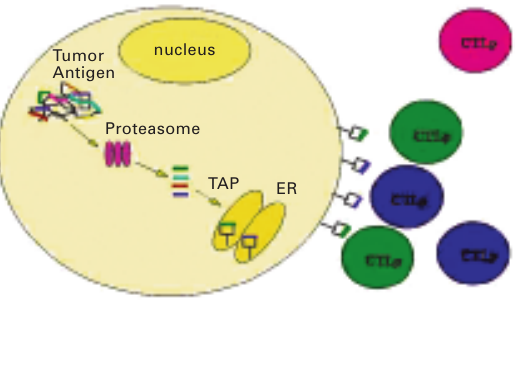
Figure 1 Peptide processing. Proteins in the cyto- plasm of cells are degraded by the pro- teosome complex, yielding short pep- tide fragments. A subset of these pep- tides are transported from the cytoplasm to the endoplasmic reticulum (ER) by transporter associ- ated protein (TAP). Once in the ER, the peptides can associ- ate with major histo- compatibility com- plex (MHC) class I molecules and move to the cell surface. Once on the cell sur- face, these com- plexes are scanned by CD8 T cells. Each CD8 T cell bears a T cell receptor able to recognise specific peptide/MHC com- plexes. Abbreviation: